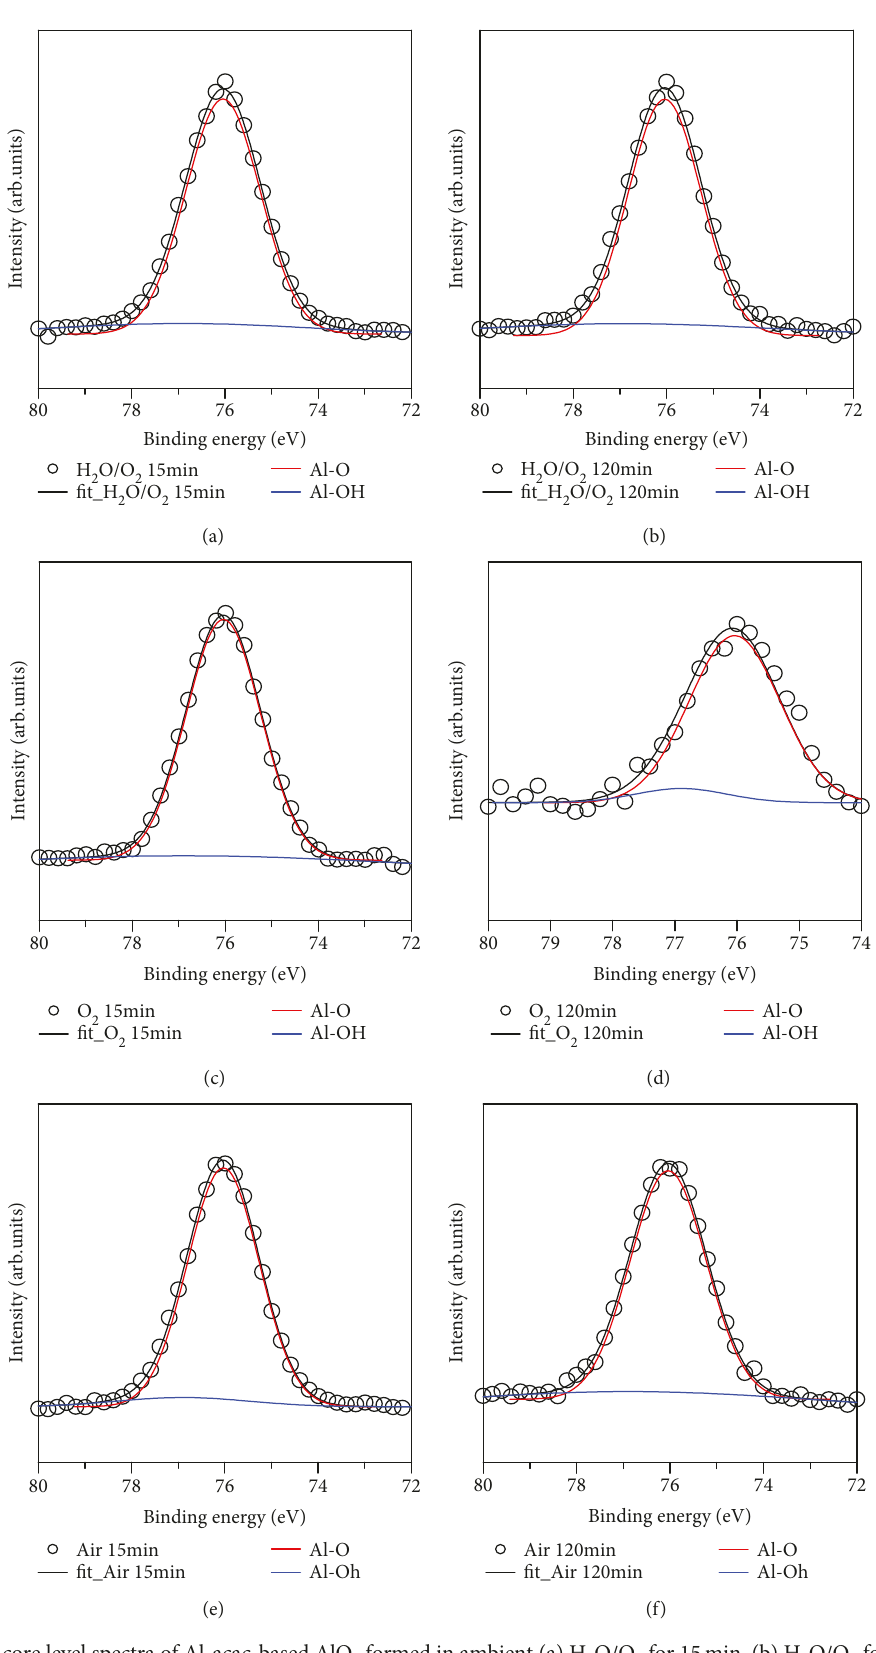
formed in ambient (a) H x